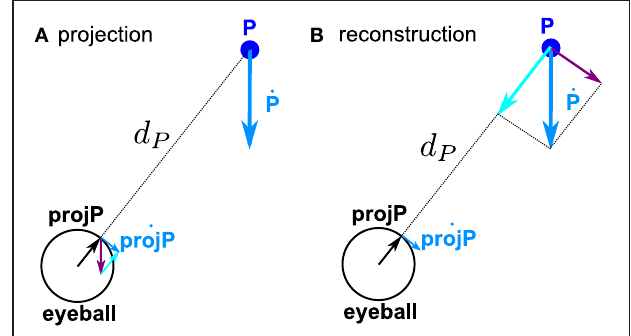
FIGURE 2 | Geometry of the velocity projection (A) and velocity reconstruction (B). (A) Projection of P position and velocity onto the eye (actually we plot the reversed retinal projection and velocity projection, to be directly comparable to the spatial position and velocity). References to the reference frame are omitted on the figure for the sake of clarity. The two components which add to obtain pro ˙ jP EE are represented : ˙ P EE − ˙ d P P EE . ( B ) Reconstruction of P position and velocity. The pro ˙ jP EE = d P d 2 P two components which add to obtain ˙ P EE are represented: ˙ jP EE + ˙ d ˙ P EE = d EE P pro P projP